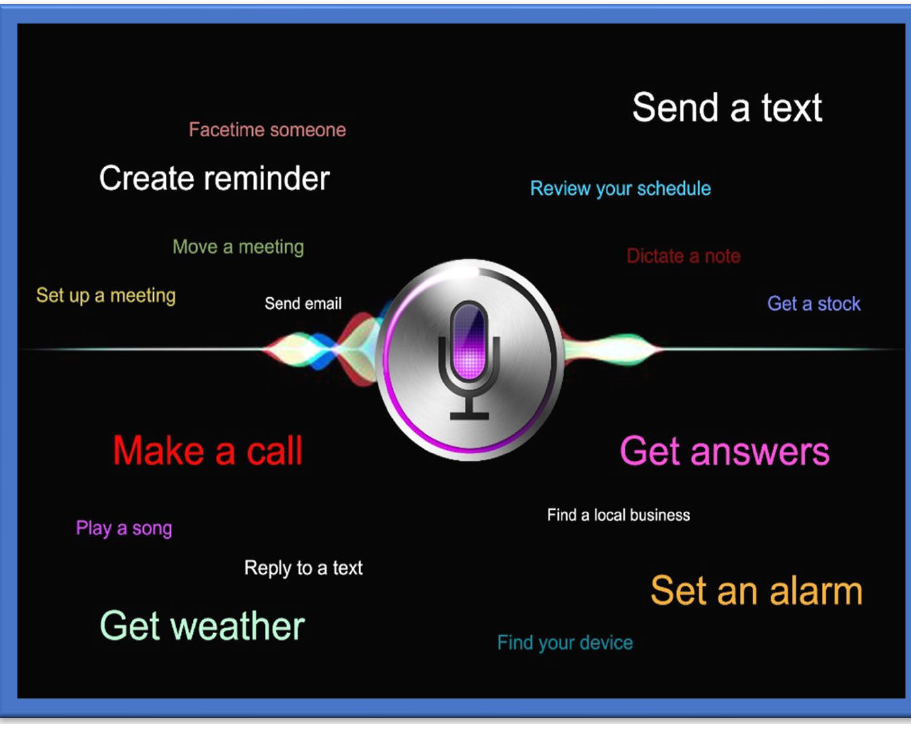
Figure 8. Siri for Figure 8. Siri for iPhone.